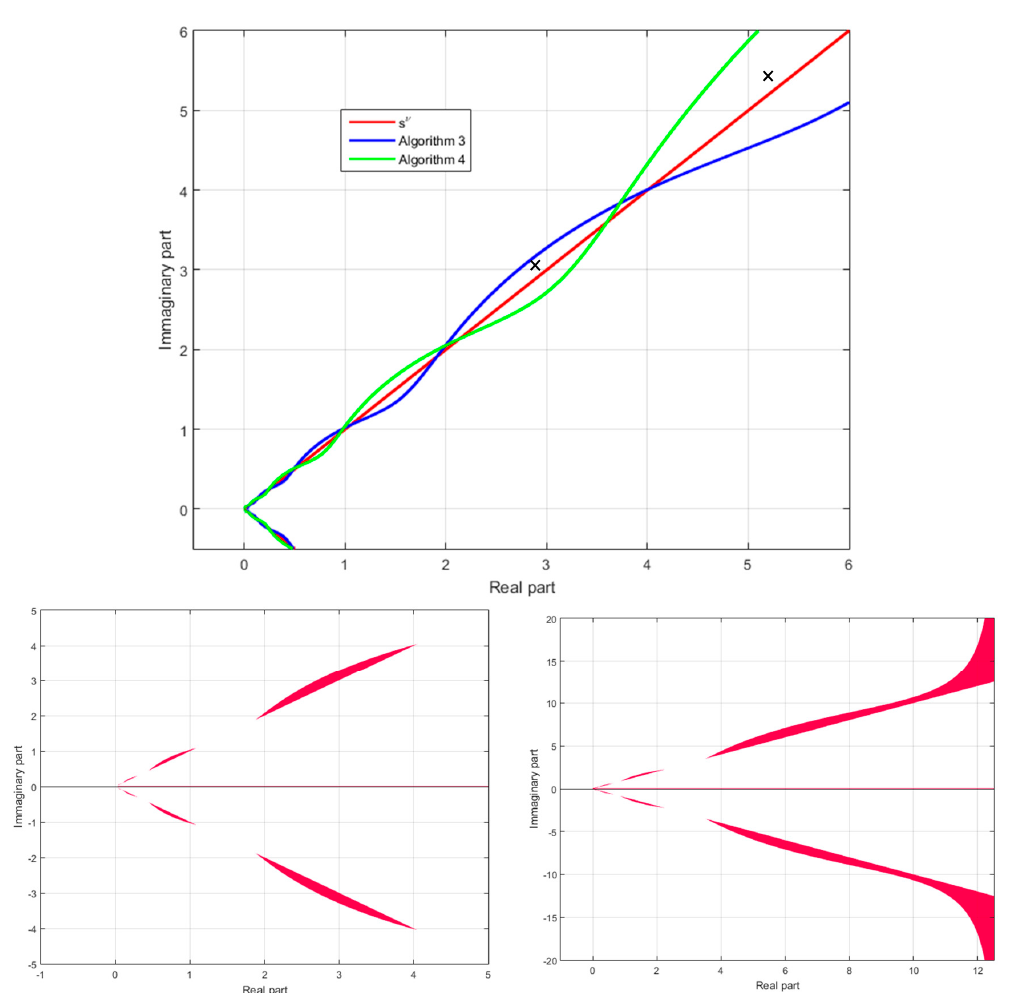
Figure 12. Impact of approximations (15) and (18) on stability model (43): illustration of stability issues ( top ), and problematic areas of the complex plane for approximation (15) ( bottom left ) and for approximation (18) ( bottom right ).